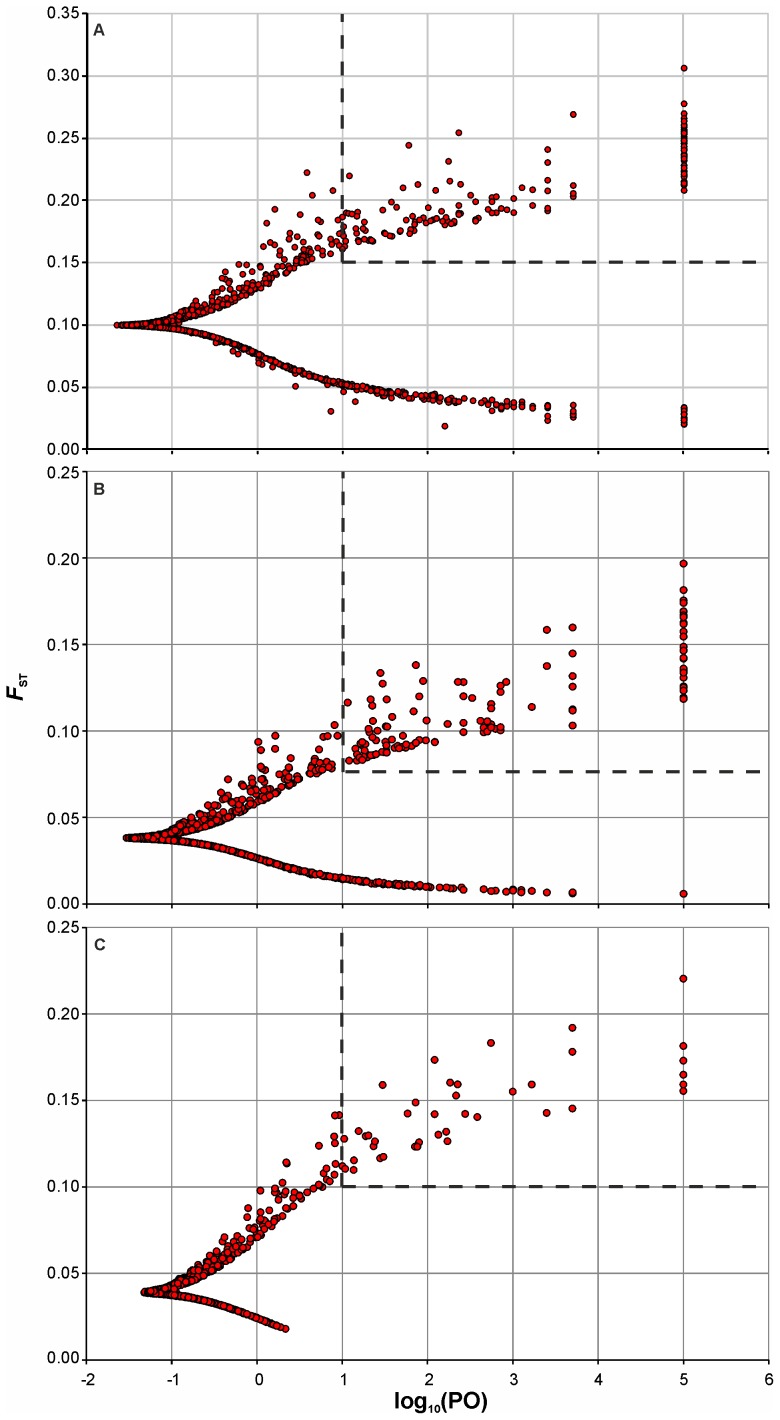
Identification of outlier loci using a model-based genome scan approach.(A) population dataset I; (B) population dataset II; (C) population dataset III. Each SNP locus (filled circle) is represented by the level of genetic differentiation (F
ST) and log10(PO) of being under selection. Outlier loci potentially under divergent selection are inside dashed rectangle.